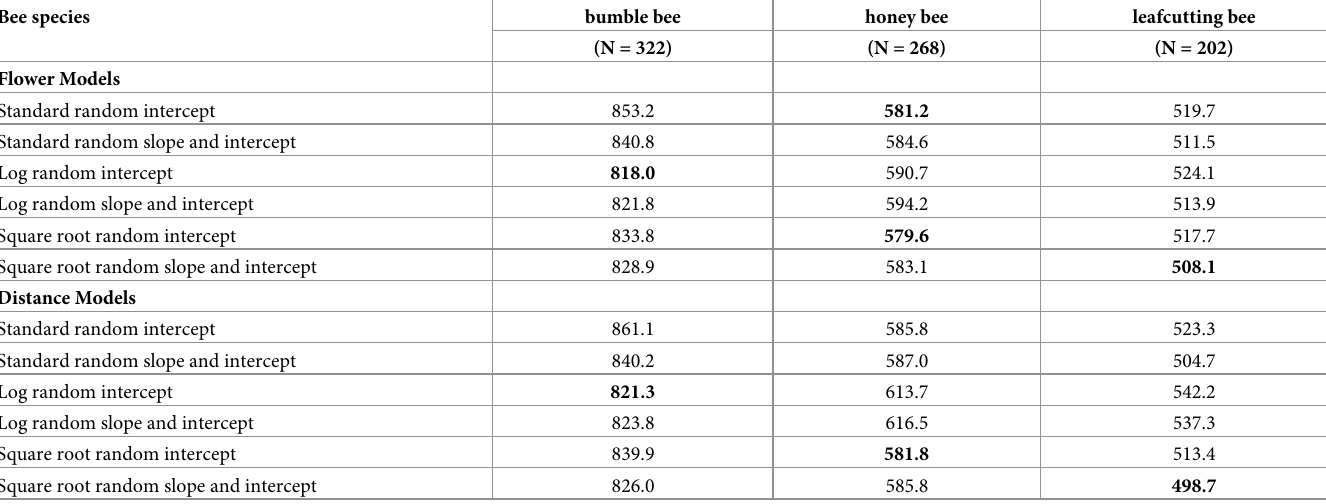
Table 1. Akaike information criterion (AIC) values for flower and distance models for three bee species. Bee species bumble